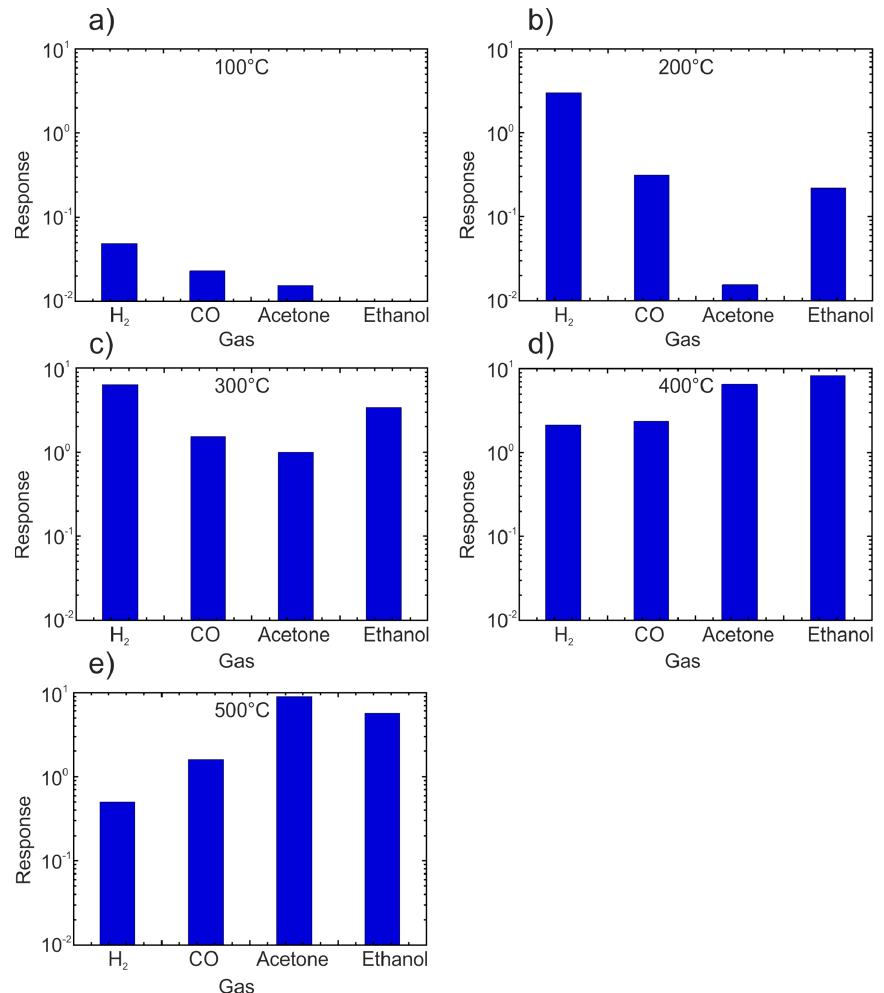
Figure 2. Response towards 500 ppm of H 2 , 500 ppm of CO, 50 ppm of acetone and 50 ppm of ethanol